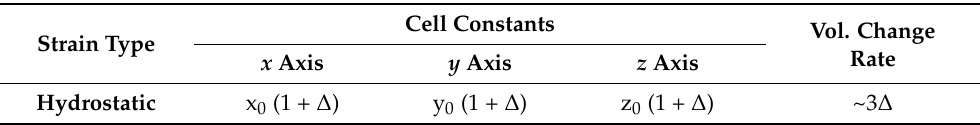
Table 1. Details of each cell deformation and calculation conditions for a representative applied strain, where ∆ corresponds to the increments from the strains applied along with the X, Y, and Z axes, respectively.